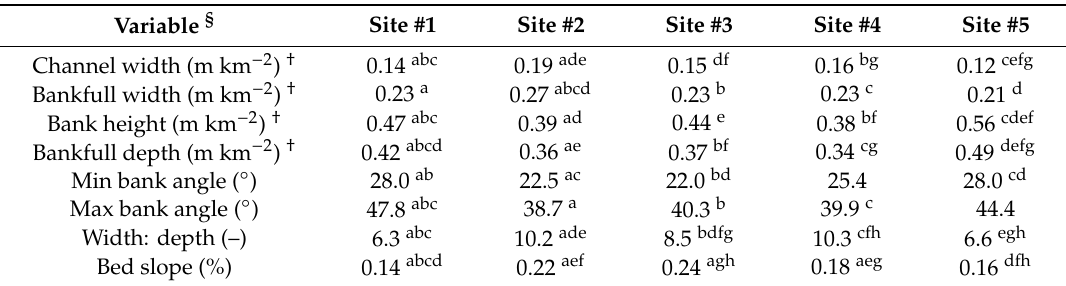
Table 3. Channel morphology metrics measured at survey sites (n = 561) and averaged within five nested sub-basins located in Hinkson Creek Watershed, Missouri, USA. Sub-basins were delineated between nested gauging sites and were thus not